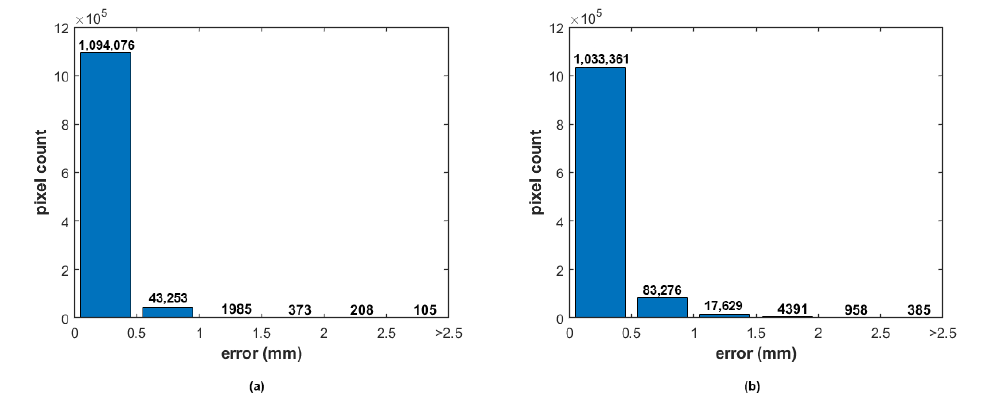
Figure 10. The distribution of errors for each measurement point for both the stationary ( a ) and scanning SFF ( b ) method. It also shows the degradation caused by the measurement